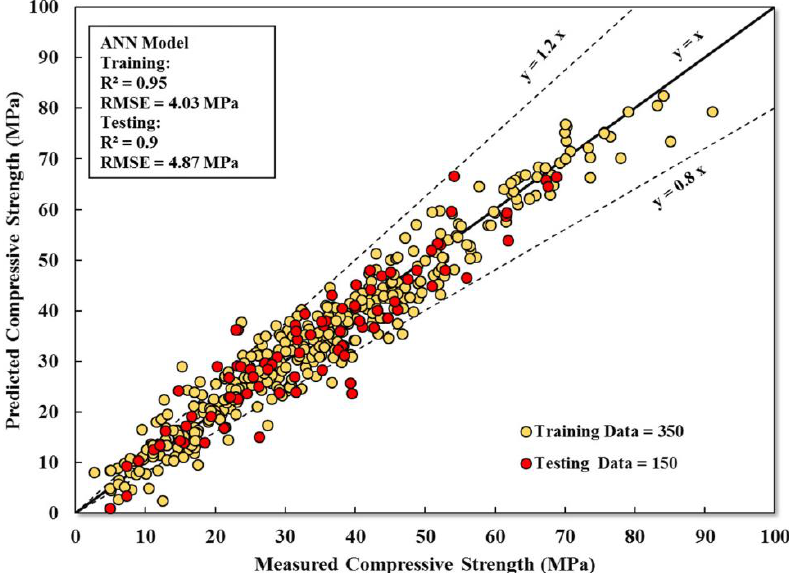
4.35 MPa for the testing dataset.